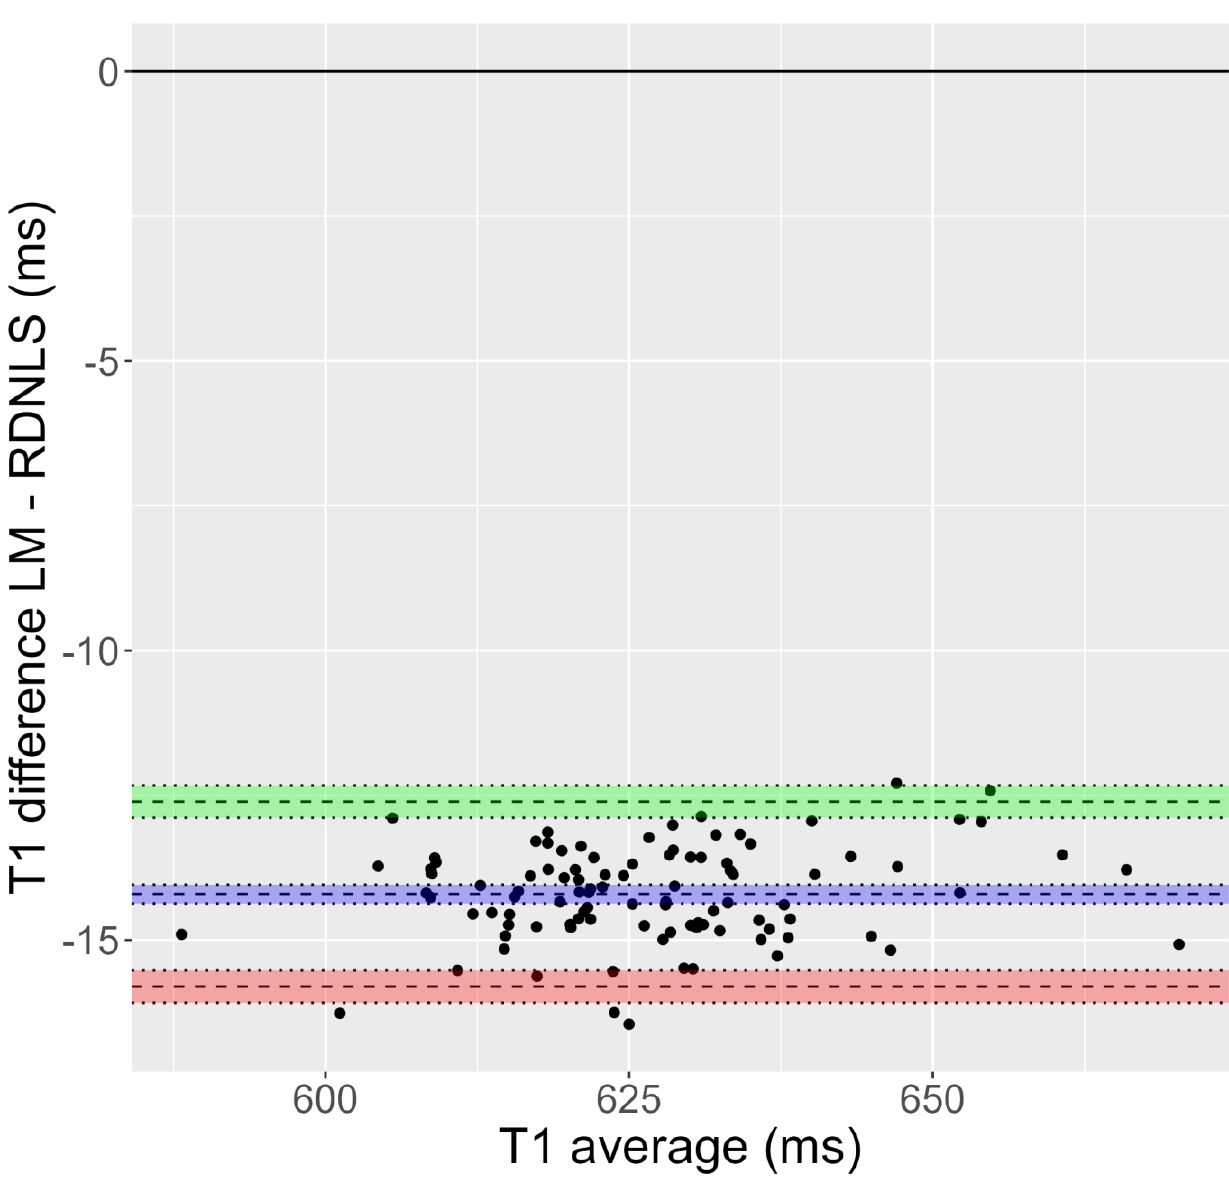
Figure 1. Bland-Altman plot corresponding to Test 1 (inversion recovery, mouse data). It is evident that the T 1 obtained by Bruker’s fit is greater than that derived from RD-NLS.